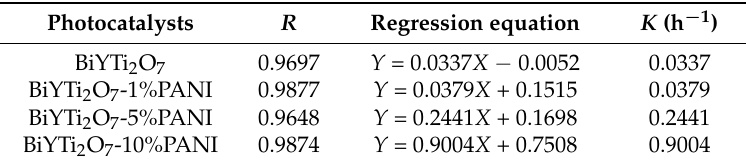
Table 3. Kinetics parameters of photocatalytic degradation of AG with BiYTi 2 O 7 , BiYTi 2 O 7 -1%PANI,